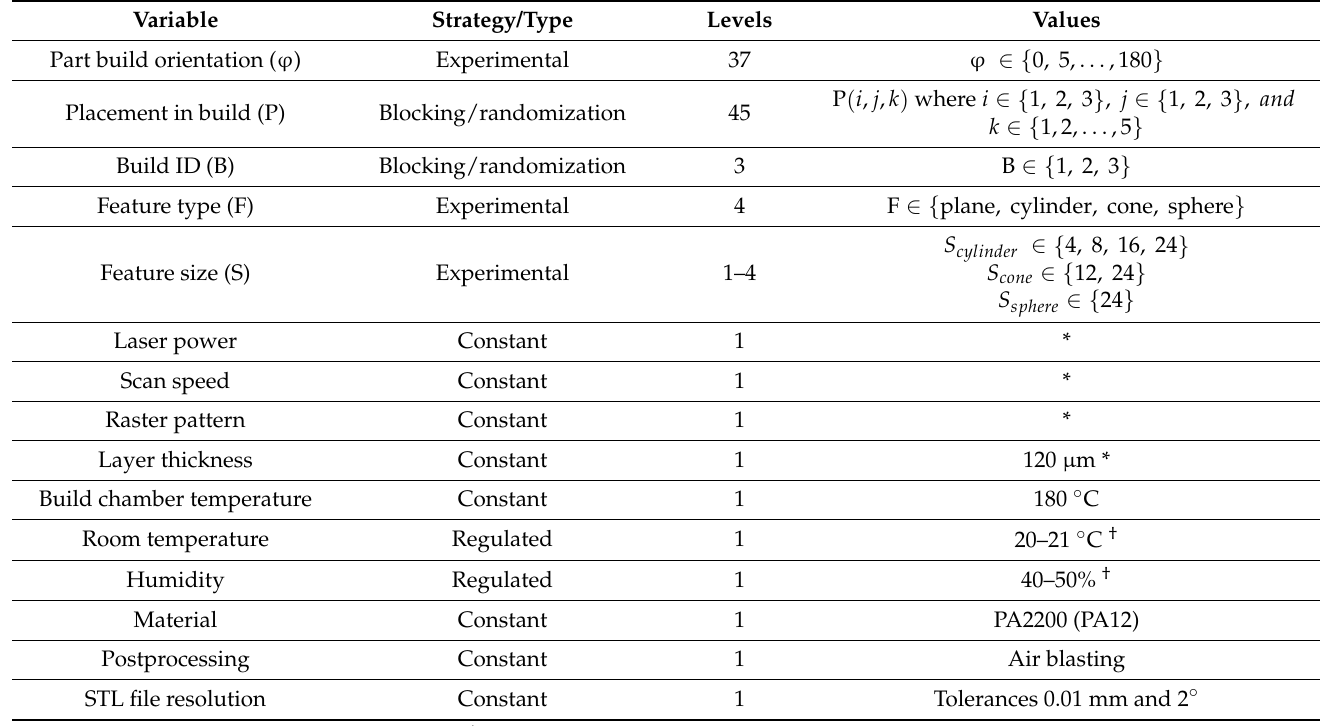
Table 1. Experiment variables with their designated type/strategy and number of levels.